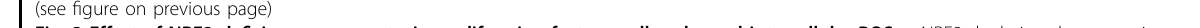
Fig. 3 Effect of NRF2 de fi ciency on apoptosis, proliferation factors, cell cycle, and intracellular ROS. a NRF2 depletion does not trigger apoptosis. 48 h after NRF2 KD induction and 16 h of hypoxia, total cell lysates were subjected to western blot analysis for PARP with Laminin A as loading control (left panel) further caspase3 activity assay was analyzed (right panel). b Proliferation factors AKT and c-Myc are not affected by KD of NRF2. Whole-cell lysates from normoxic and hypoxic samples were prepared 72 h following NRF2 KD induction. Western blot analysis compared phospho-AKT (S473) and c-Myc protein levels, actin served as a loading control. c Cell cycle progression is independent of NRF2. PANC1-shNRF2 (left panel) and A549-shNRF2 cells (right panel) were incubated for 96 h after NRF2 KD under normoxic or hypoxic conditions before nuclei were stained with PI and analyzed for DNA content by FACS. d NRF2 counteracts oxidative stress independent of the oxygen level. PANC1-shNRF2 (left panel) and A549-shNRF2 cells (right panel) were incubated as under c . After 96 h, CellROX reagent (5 µM) was added to the culture medium for 2 h in order to visualize oxidative stress. The upper panels display representative fl uorescence images. For each condition, 12 randomly chosen areas